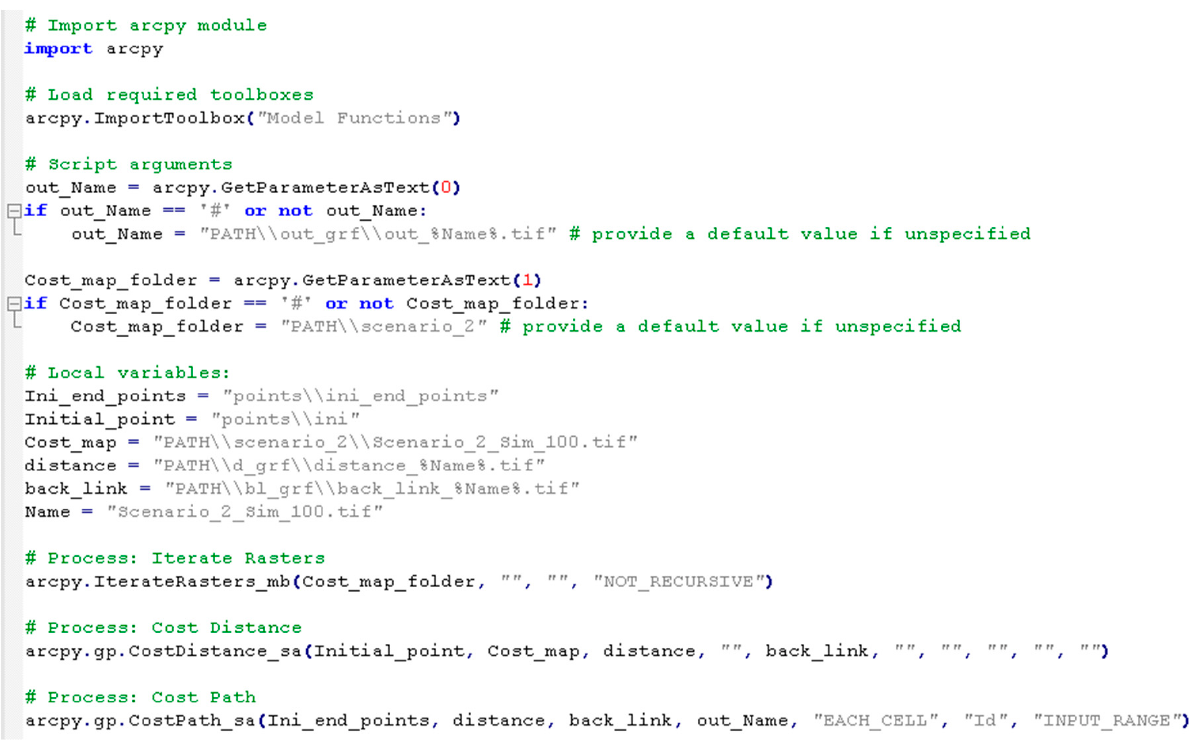
Figure A3. Python code from the model builder.